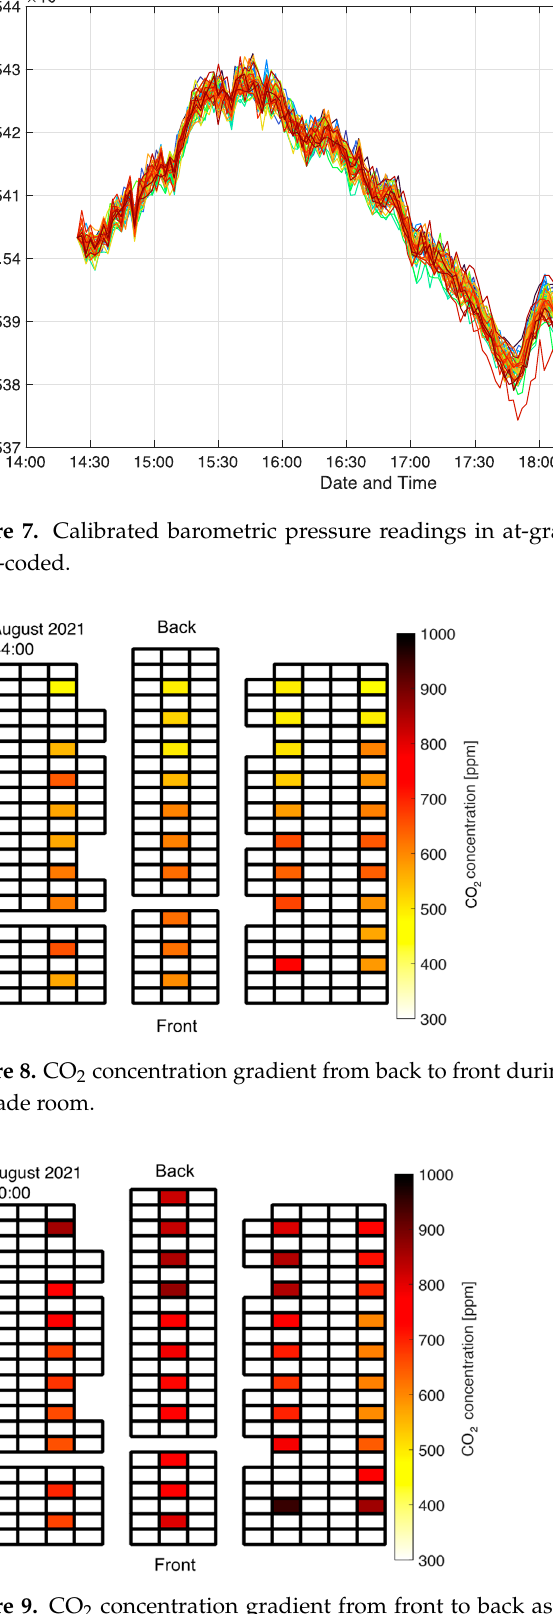
Figure 9. CO 2 concentration gradient from front to back as students left the at-grade room after the exam.